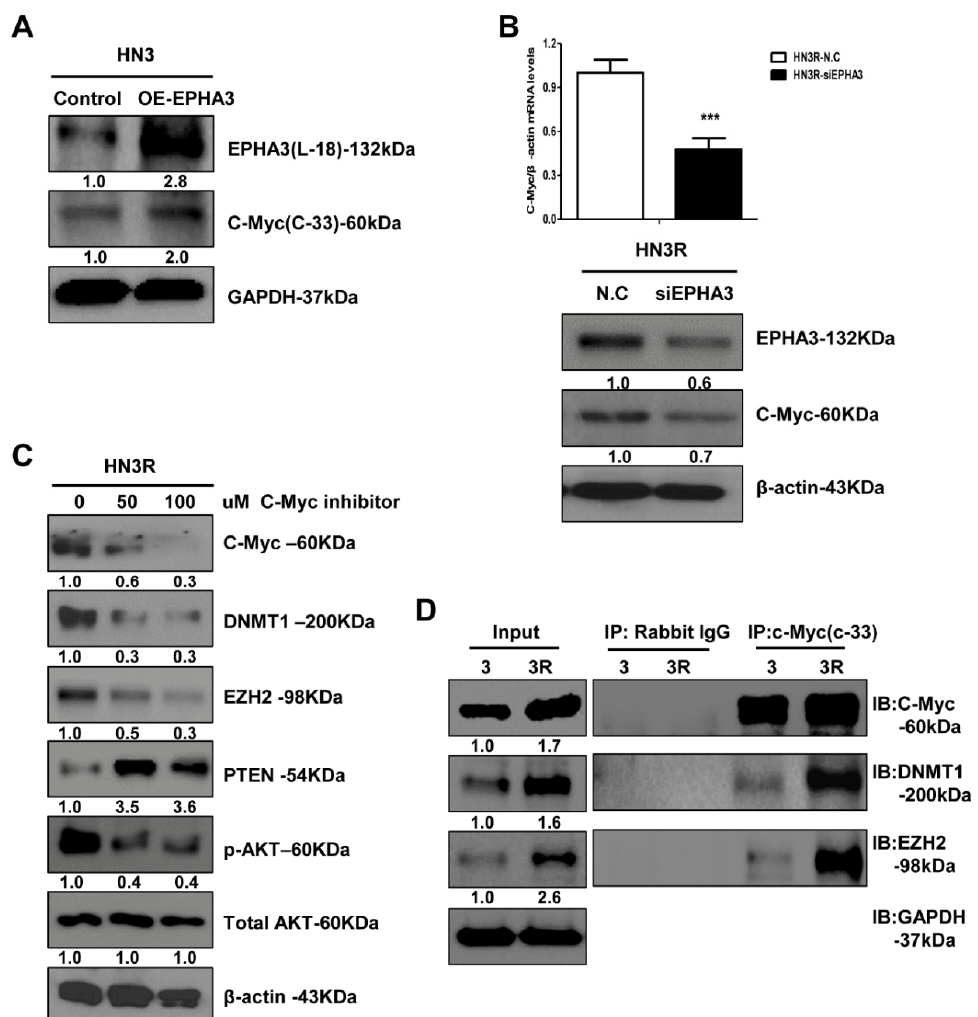
Figure 3. PTEN is repressed by EZH2-mediated histone methylation and DNMT-mediated DNA methylation via the EPHA3/c-Myc pathway in radioresistant head and neck cancer cells. ( A ) C-Myc protein expression after transfection of EPHA3 in HN3 cells. ( B ) C-Myc mRNA and protein expression after the silencing of EPHA3 in HN3R cells. ( C ) Expression of EZH2, DNMT1, PTEN, pAkt, and total Akt after treatment with the c-Myc inhibitor. ( D ) Assessment of direct interaction between DNMT1/EZH2 and c-myc using immunoprecipitation (IP). *** p <